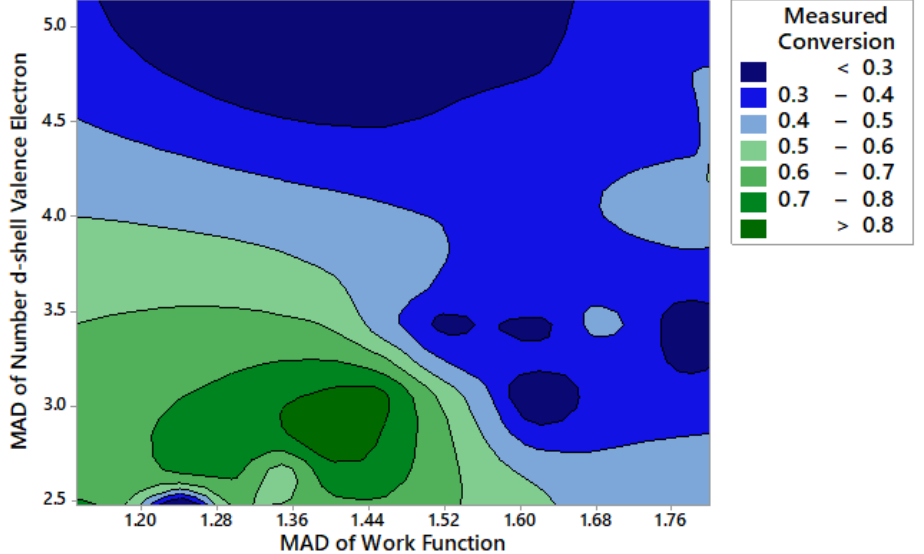
Figure 3. Ammonia decomposition activity at 300 °C as a function of the mean absolute deviation (MAD) of the number of d-shell valence electrons and the MAD of the catalyst work function.